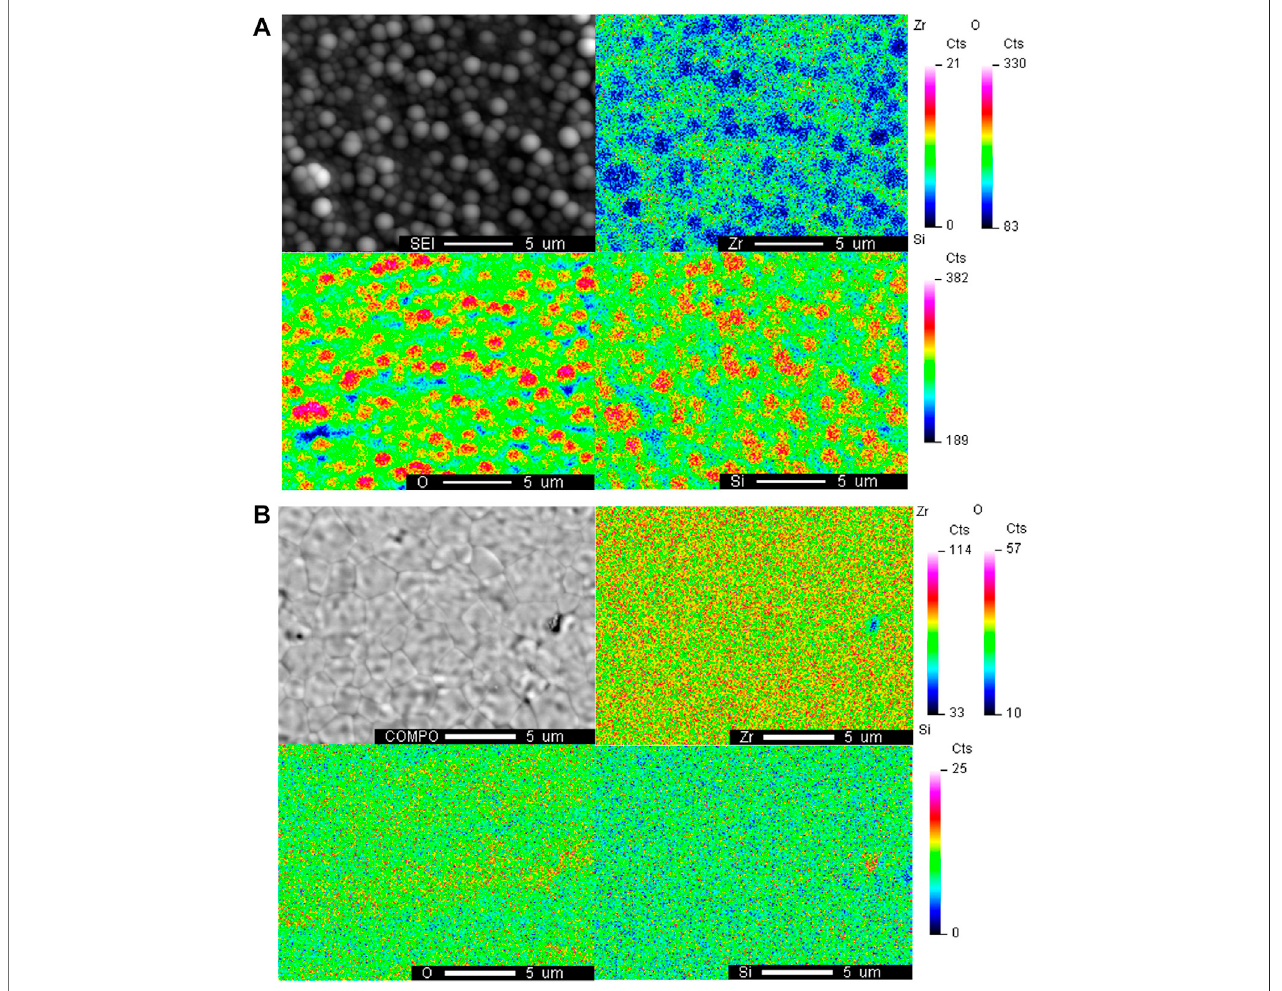
FIGURE 5 | WDS elemental mapping of the surface of YSZ pellet with H 2 +N 2 +siloxane contamination after (A) D4 contamination and (B) L4 contamination at 750 ° C.